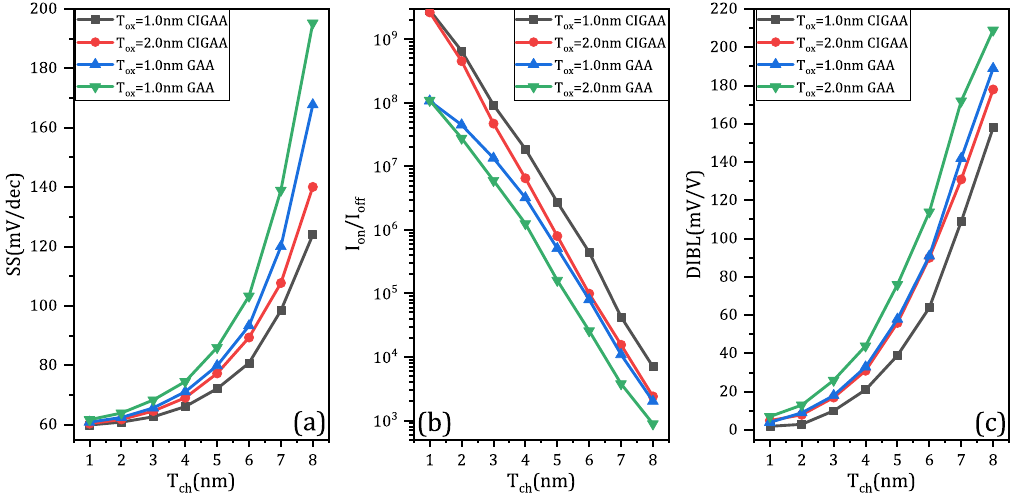
Figure 7. The simulation results of CIGAA and GAA: ( a ) subthreshold slope (SS) of CIGAA and GAA; ( b ) switching ratio (I on /I of f ) of CIGAA and GAA; ( c ) drain-induced barrier lowering (DIBL) of CIGAA and GAA. All three of the figures are plotted when D CI = 4.0